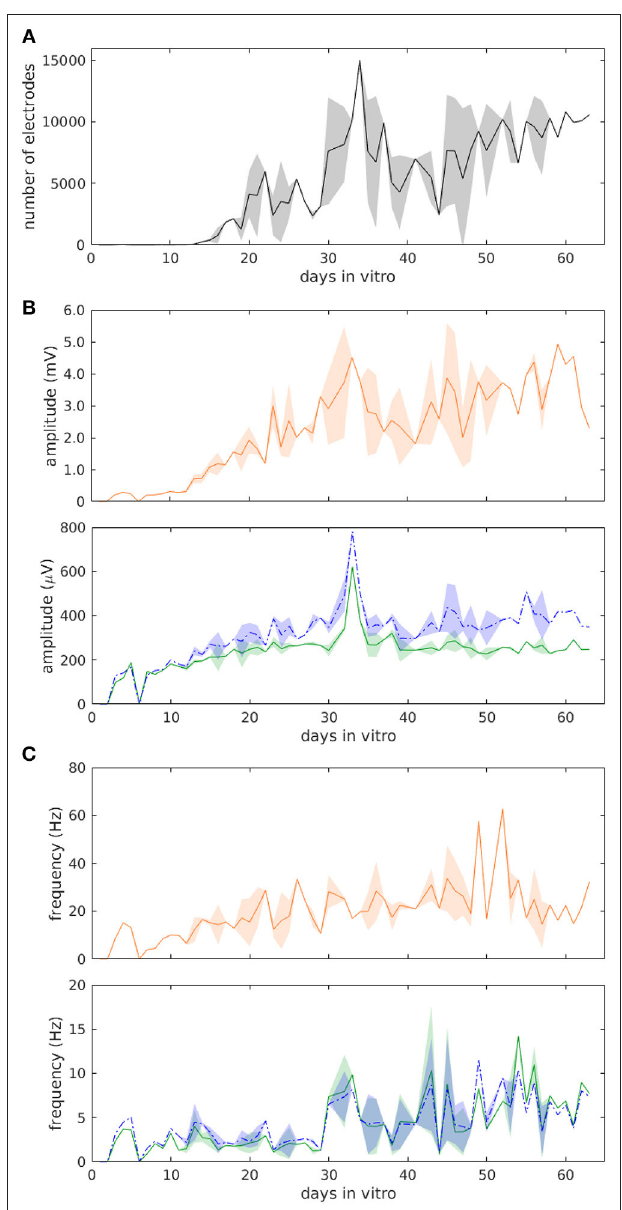
FIGURE 2 | Statistics of muscle cell evolution over more than 60 days from three cultures. (A) Number of active electrodes. (B) Average spike height. (C) Average spiking frequency. Green (solid) traces show mean, blue (dotted) traces show median ± SD, and orange traces in (B,C) show the maximum